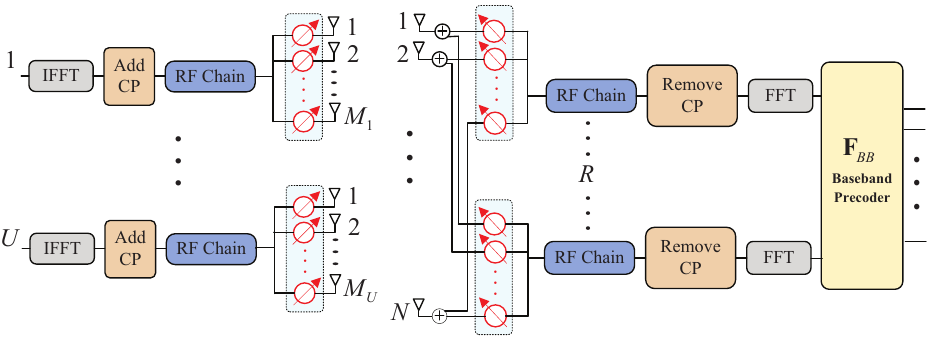
Figure 1. Architecture of multiuser mmWave massive MIMO-OFDM